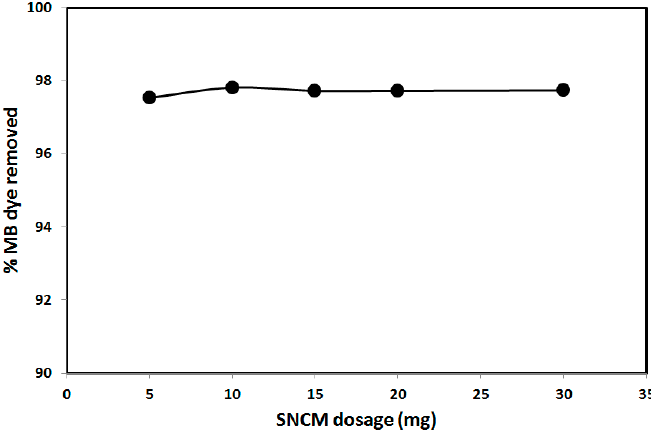
Figure 5. Effect of the SNCM dosage on the removal of methylene blue dye from an aqueous solution.